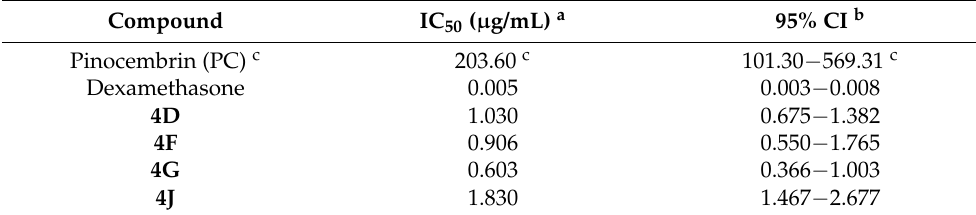
Table 3. Inhibitory response of PC and selected derivatives on NO produced by LPS-induced